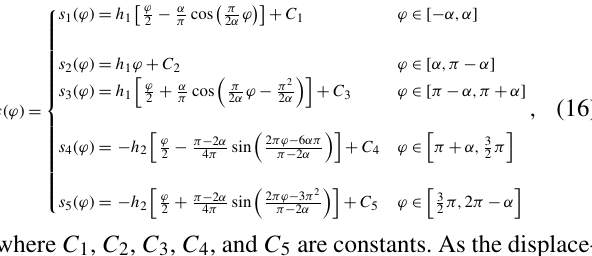
the base circle radius is smaller than s min , and the difference is the follower radius. Similar results are also obtained for three-piston pumps, as discussed in Sect.